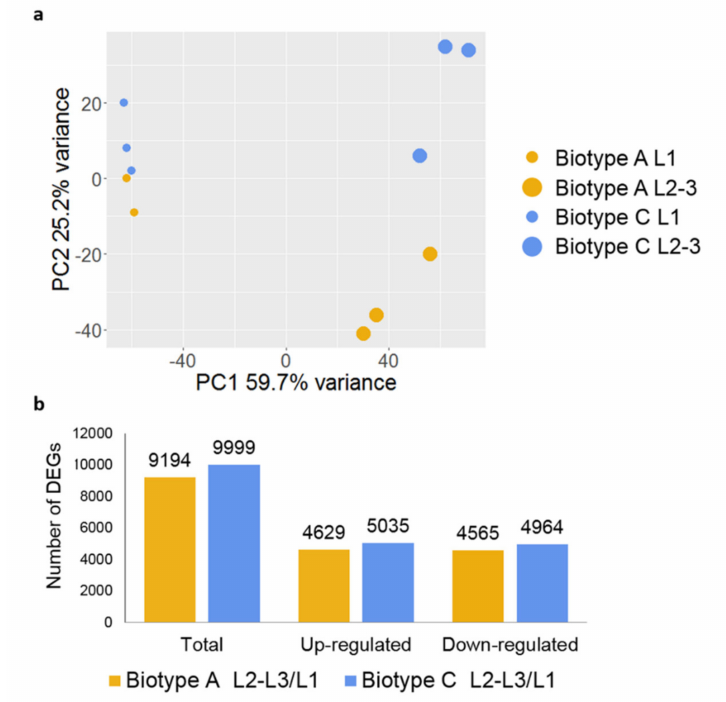
Figure 2. ( a ) Principal component analysis between the phylloxera transcriptome samples collected from biotype A (yellow) and C (blue) in phylloxera larval stage L1 (small circle) and L2-3 (big circle); ( b ) Di ff erentially expressed genes in the two biotypes in the phylloxera larval stage L2-3 compared to L1. Yellow and blue colors represent biotype A and C,